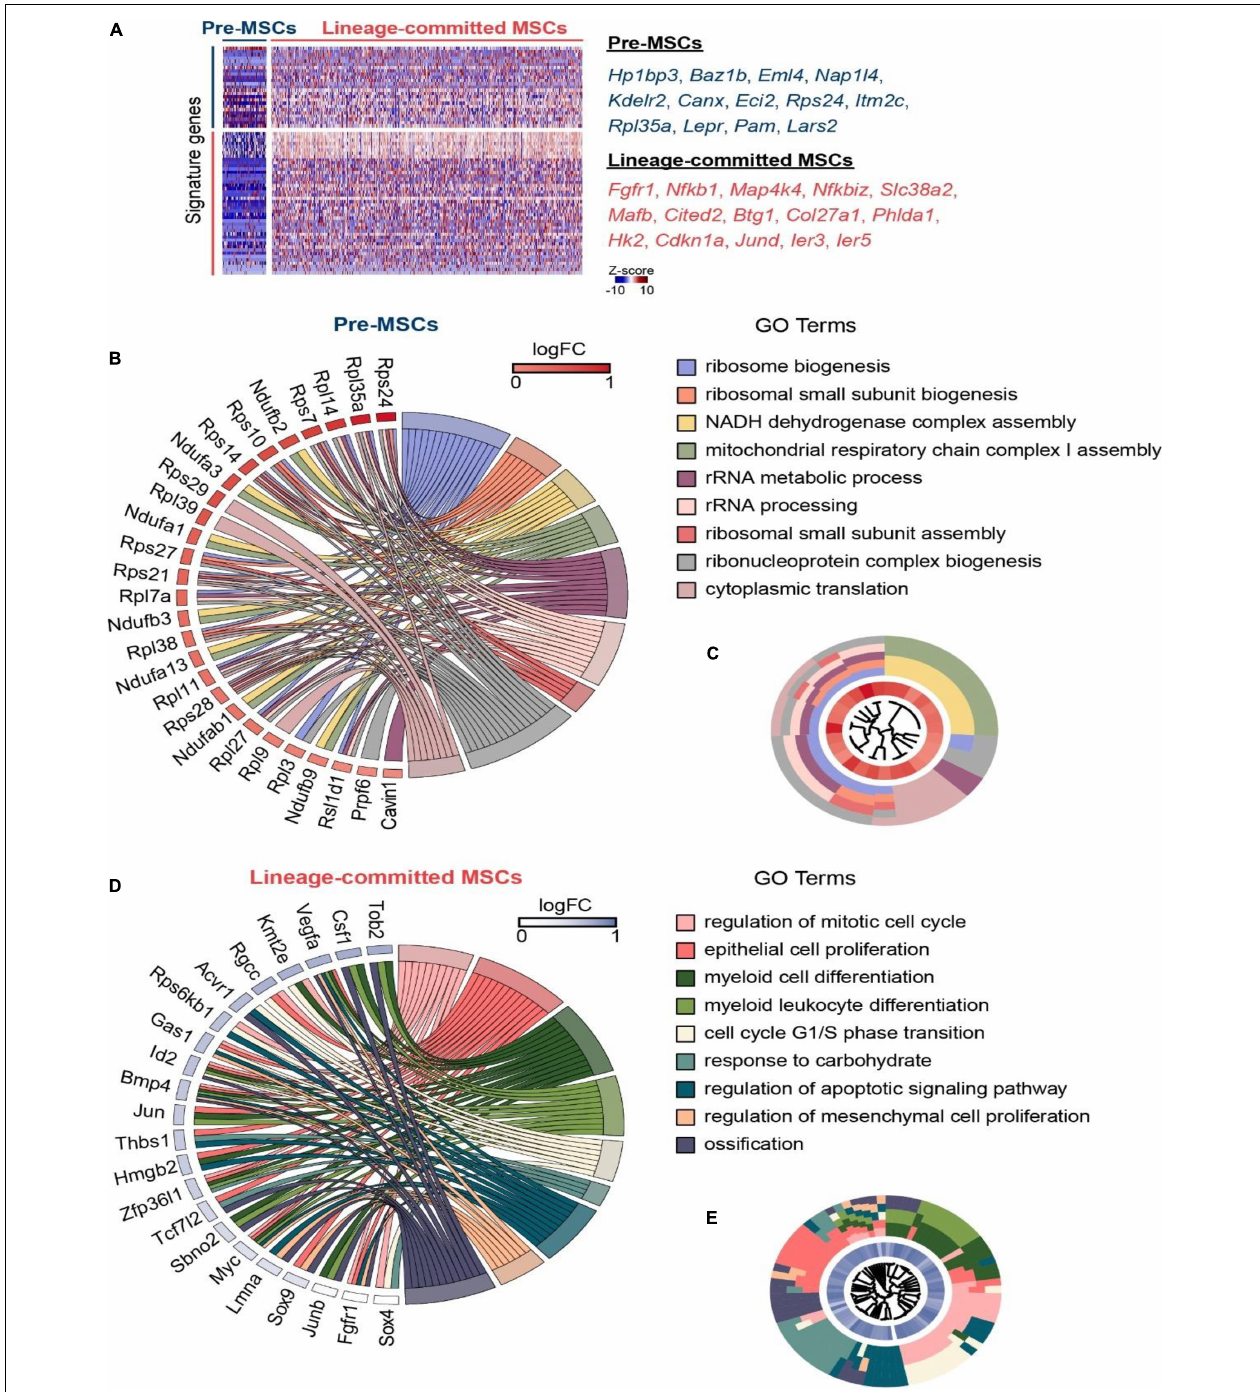
FIGURE 2 | Single-cell atlas identifies pre-MSCs and lineage-committed MSCs. (A) Heat map of signature genes in pre- or lineage-committed MSCs; exemplar genes are listed on right. Columns denote cells; rows denote genes. (B) GOChord plot showing the association between statistically significant genes in pre-MSCs and their associated GO terms; the genes are associated via ribbons to their assigned terms. White-to-red coding next to the selected genes indicates the gene expression fold change. The outer ring shows the assigned functional terms. (C) GOCluster plot showing the clustering of the pre-MSC signature gene expression profiles. The inner ring shows the color-coded expression fold changes, and the outer ring shows the assigned functional terms as indicated in (B) . (D) GOChord plot showing the association between statistically significant genes in lineage-committed MSCs and their associated GO terms; the genes are associated via ribbons to their assigned terms. White-to-blue coding next to the selected genes indicates the gene expression fold change. The outer ring shows the assigned functional terms. (E) GOCluster plot showing the clustering of the lineage-committed MSC signature gene expression profiles. The inner ring shows the color-coded expression fold changes, and the outer ring shows the assigned functional terms as indicated in (D)